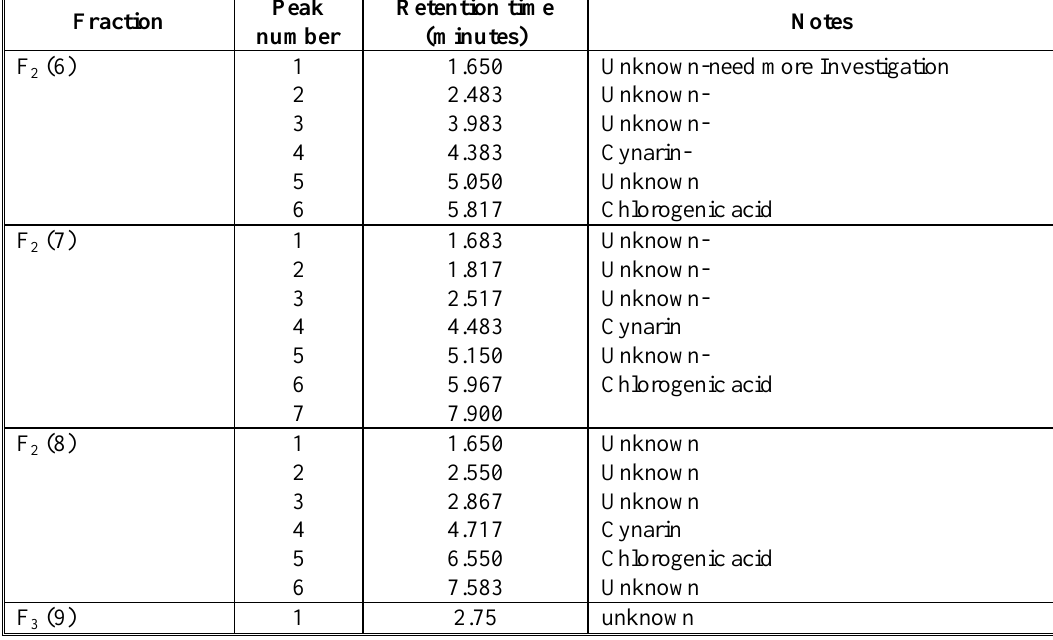
Table 4 : Butanol layer fractions and their content from phenolic acids, after separation in HPLC